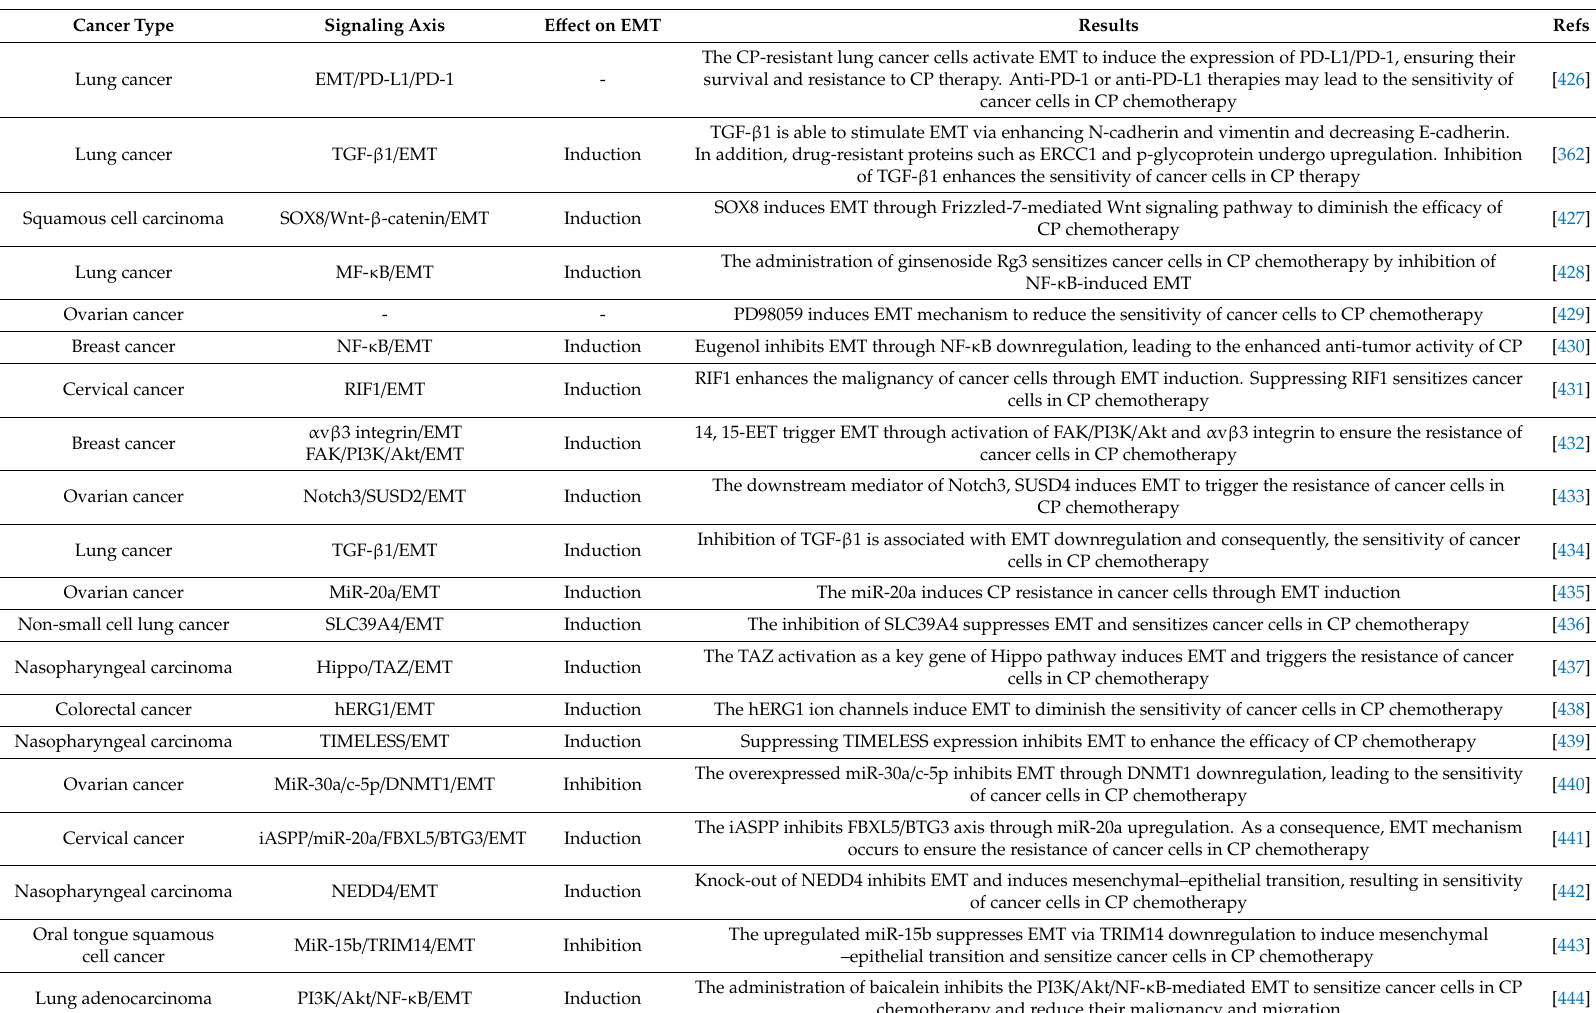
Table 1. The involvement of diverse molecular pathways in EMT-mediated resistance to CP